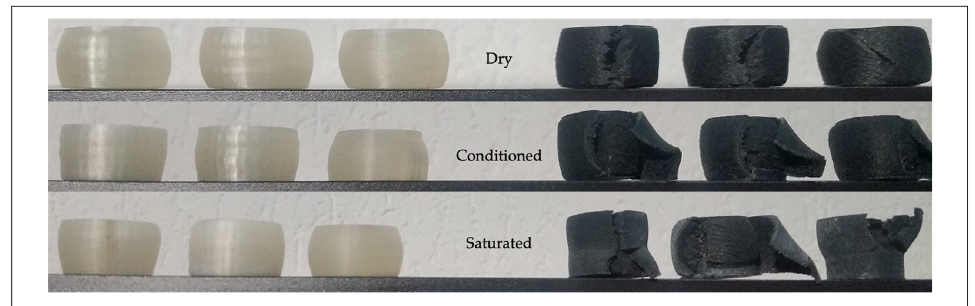
Figure 10. Dry, conditioned, and saturated specimens at the end of the tests.